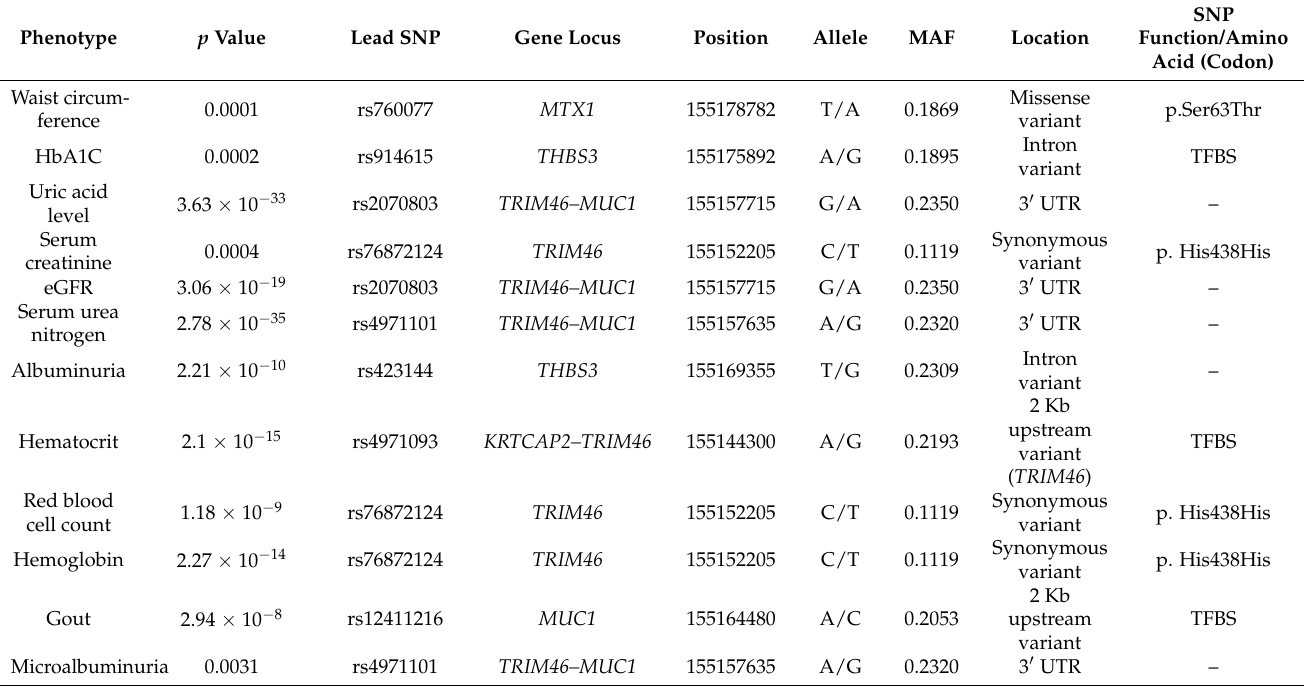
Abbreviations as in Table 1. TFBS: transcription factor binding site, SNP: single-nucleotide polymorphism, MAF: minor allele frequency, UTR: un-translated